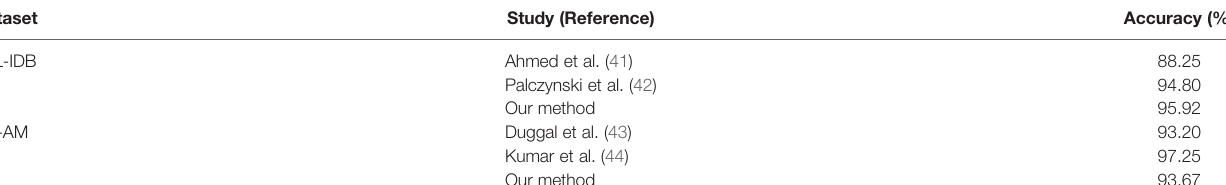
TABLE 2 | Performance on ALL-IDB, SN-AM for different backbone studies.